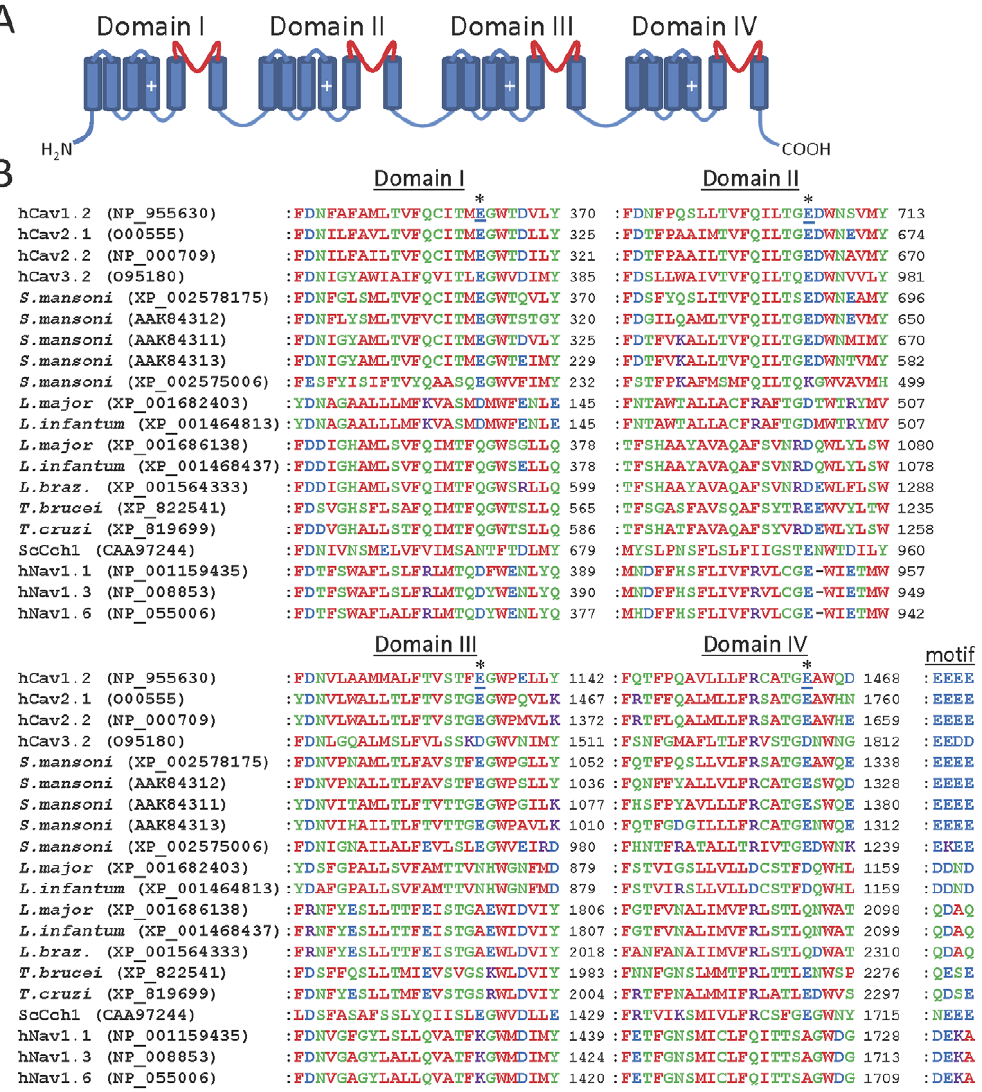
Figure 6. Parasite Ca v channel homologues show similarity to human Ca v channels in the pore region. (A) Schematic showing the four- domain structure of human Ca v channels, with the pore loop of each domain shown in red. Cylinders indicate TMDs, and plus signs indicate the charged voltage sensor regions. (B) Multiple sequence alignments of the pore domains of human Ca v channels with parasite Ca v channel homologues. Only those parasite homologues containing four putative domains are shown. Sequences of human Ca v 1.2 (L-type), Ca v 2.1 (P/Q-type), Ca v 2.2 (N-type) and Ca v 3.2 (T-type) channels, as well as the S. cerevisiae Cch1 Ca 2 + channel (ScCch1), are shown. L. braz denotes L. braziliensis . Selected human Na v isoforms are included, to allow comparison with the related Ca v channels. The locations of acidic residues (underlined) forming an acidic ring motif in human Ca v 1.2 channels are indicated by asterisks. The overall motif formed by all four domains at this locus is indicated to the right of the Domain IV alignment for each channel homologue.